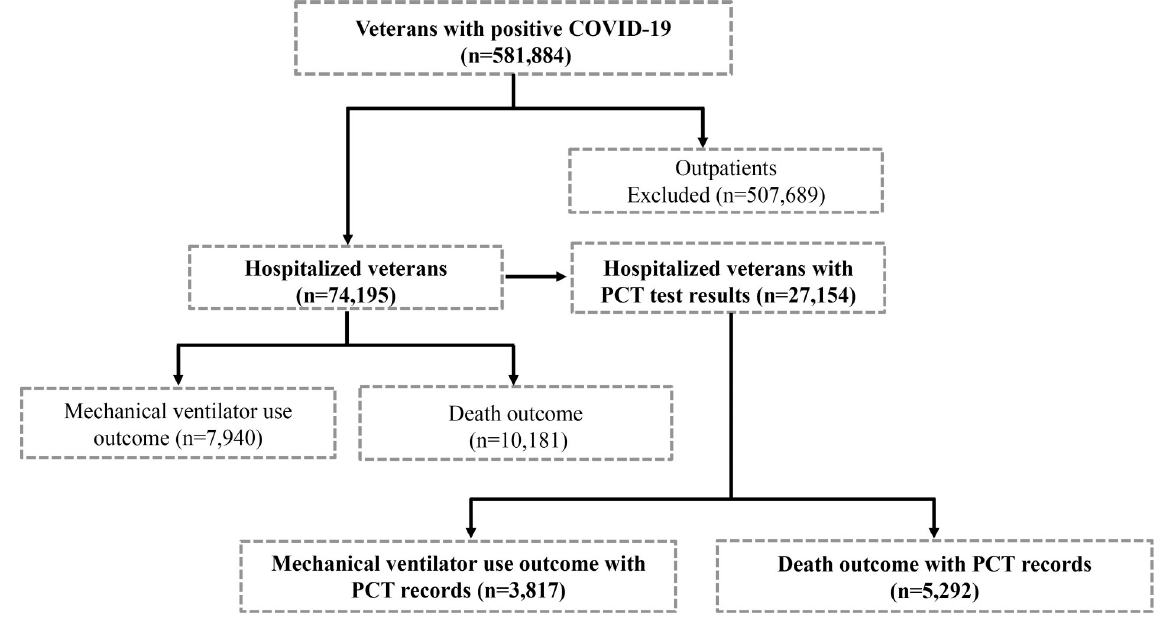
Fig 1. A flow chart showing the reported COVID-19-positive cases amongst veterans with and without the records of serum PCT test results between March 1, 2020, and February 28,